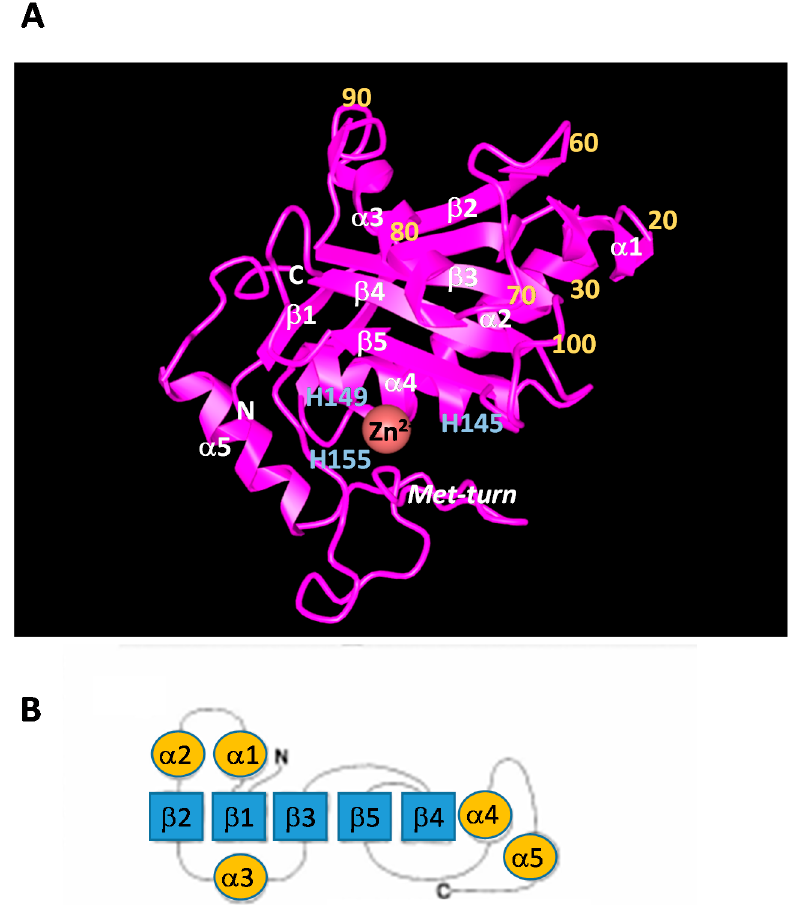
Figure 2. ( A ) Three-dimensional structure of the M domain of an H 2 -proteinase derived from Protobothrops flavoviridis venom [19]. α 1– α 5: α -helices; β 1– β 5: β -sheet; Yellow number shows amino acid position; Light blue shows His residues in Zn 2+ -binding sequence; ( B ) Topological packing diagrams for H 2 -proteinase derived from P. flavoviridis venom.